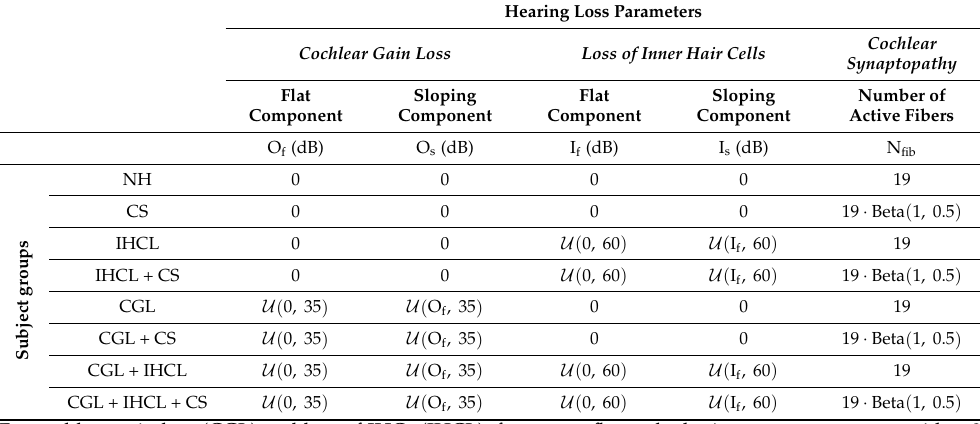
Table 1. Distributions of hearing loss parameters Ψ = { I f ,I s ,O f ,O s ,N fib } with regard to sub- ject groups.